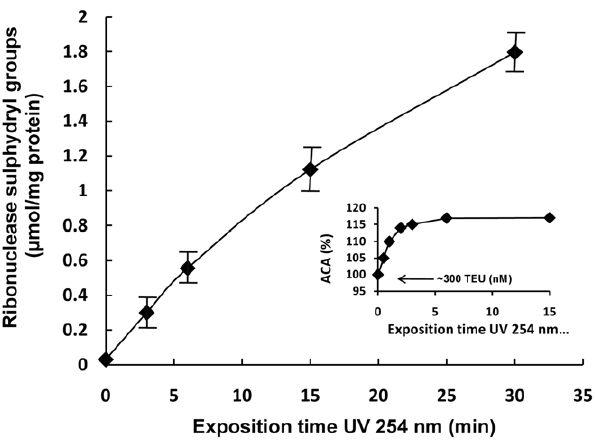
Figure 6. Thiol groups in Ribonuclease A exposed to UV light and antioxidant behavior of the protein. UV light (254 nm) exposed thiols from disulphide’s ribonuclease groups in a time dependent manner. In the internal graph, ribonuclease in the native state showed an elevated antioxidant capacity ( , 300 TEU, nM), but in contrast, the change in antioxidant capacity represented as ACA% after UV light exposure was relatively short and did not exceed 116–120% independent of the exposure time above 5 min. Results are expressed as mean + SD of three experiments. The internal graph corresponds to a representative